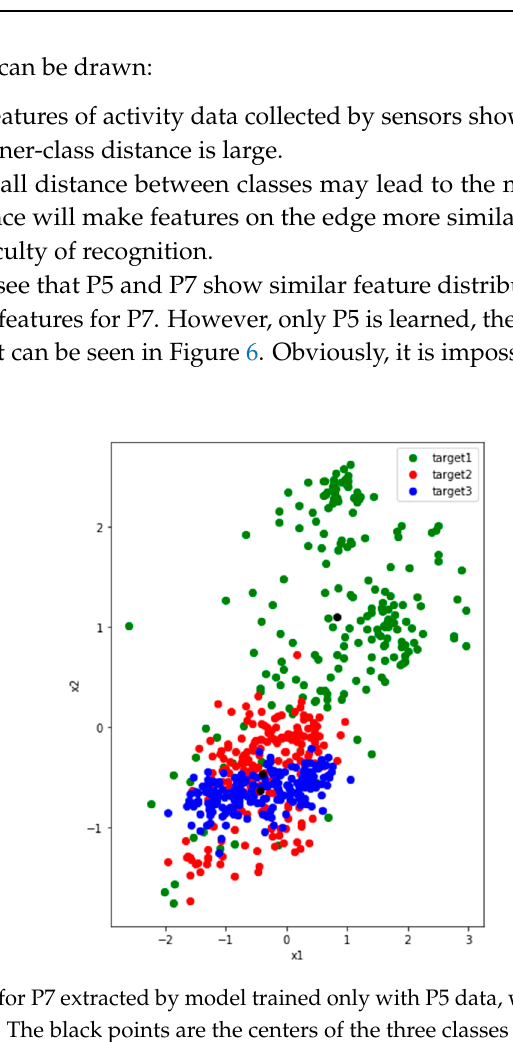
Figure 6. The features for P7 extracted by model trained only with P5 data, which are mixed, dispersed, and indistinguishable. The black points are the centers of the three classes of